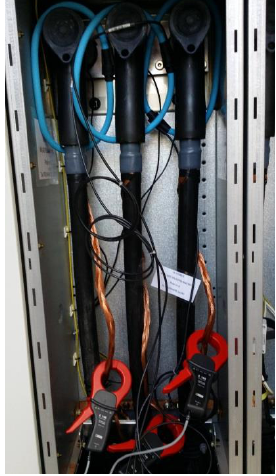
Figure 5. Measurement of currents flowing in cores and sheaths in Substation 2.